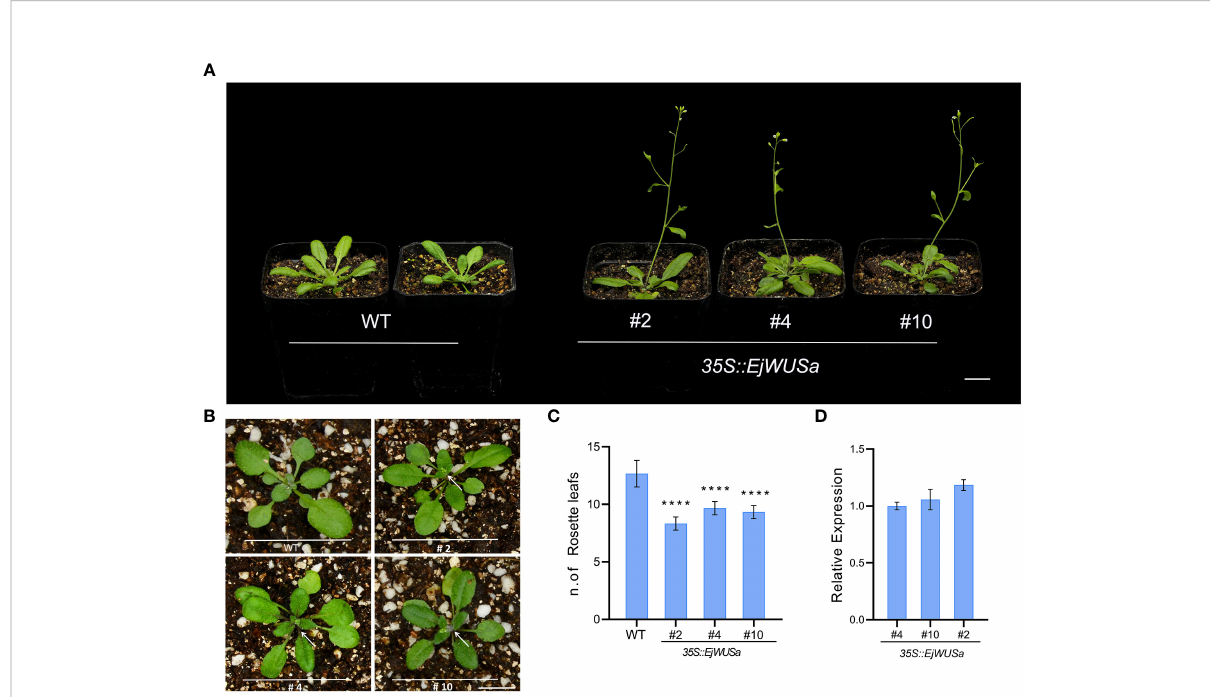
FIGURE 8 Overexpression of EjWUSa promotes Arabidopsis fl owering. (A) 35S::EjWUSa transgenic lines showed early fl owering compared to WT. Bars = 1cm. (B) 35S::EjWUSa transgenic lines showed early bolting compared to WT. Bars = 1cm. (C) The number of rosette leaves of 35S::EjWUSa transgenic lines and WT while blooming. (D) The expression level of EjWUSa in 35S::EjWUSa transgenic lines and WT. The leaves of 35S::EjWUSa transgenic Arabidopsis and WT were collected after fl owering and used for qRT-PCR analysis. Error bars indicate SE from three biological replicates. Asterisks indicate signi fi cant differences between 35S::EjWUSa transgenic lines and WT, ****p < 0.0001, by One-way